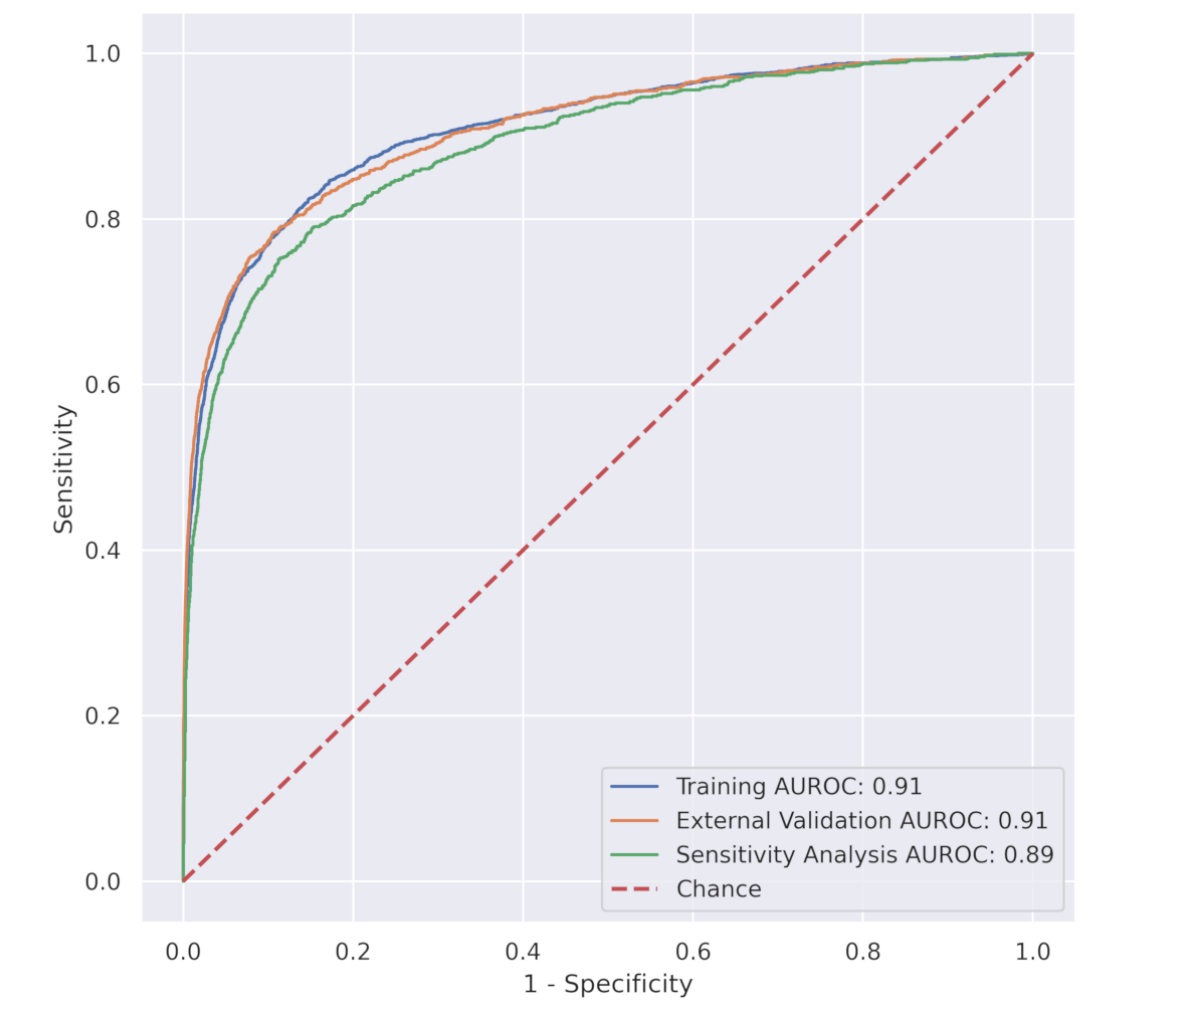
Figure 1. Discrimination as assessed by ROC curves for training, external validation, and sensitivity analysis data sets. ROC curves for the 3 different data sets: training (blue), external validation (orange), and sensitivity analysis (green). The training curve was obtained through 5-fold cross-validation, where positive controls are PCR-confirmed cases during the pandemic (N=2183) and negative controls are prepandemic patients (N=10,000) from 43 hospitals in the PHD. The training AUROC was 0.91 (95% CI 0.90-0.92). The external validation curve was performed in the external validation data set after training the model on the training data set. External validation positives are PCR-confirmed cases from Cedars-Sinai Medical Center (N=68) and from the PHD holdout set (N=952) comprising 21 hospitals. External validation negatives are prepandemic (2019) patients, from the same 21 PHD hospitals, that match the top 20 primary non–COVID-19 diagnoses in 2020 (N=154,341), as well as all eligible prepandemic (2008-2019) Beth Israel Deaconess Medical Center patients (N=17,393). The AUROC in the external validation data set was 0.91 (95% CI 0.90-0.92). The sensitivity analysis curve demonstrates the effect of using prepandemic patients as negative controls compared to using PCR-negatives from 2020. In this data set, both positives (N=952) and negatives (N=6890) were PCR-confirmed patients from the PHD holdout set (21 hospitals), and no prepandemic data was included. The AUROC in the sensitivity analysis set was 0.89 (95% CI 0.88-0.90). AUROC: area under the receiver operating characteristic